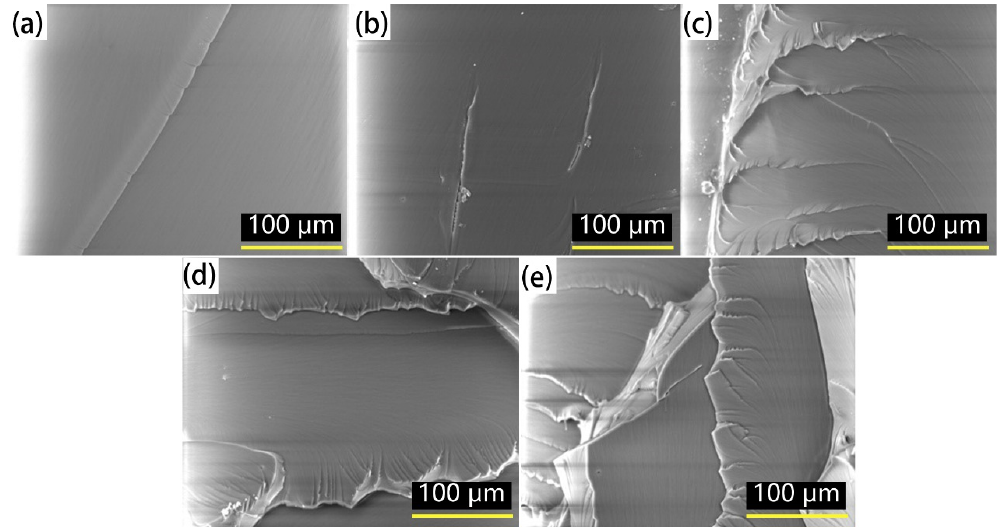
Figure 6. Micrographs of the fracture surface of the stretched modified epoxy resin with different